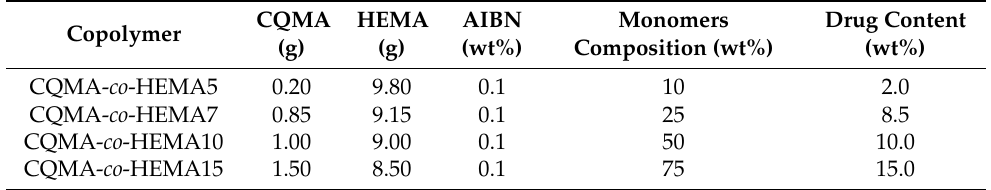
Table 2. Experimental conditions of the synthesis of CQMA- co -HEMA copolymer with different CQMA